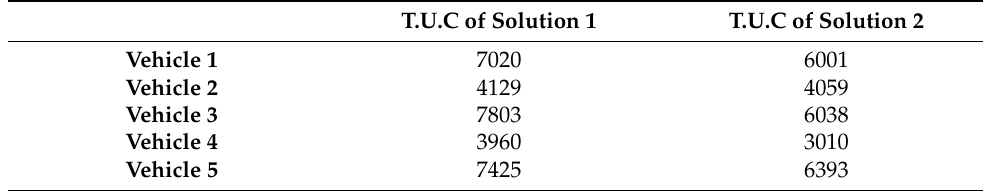
Table 8. T.U.C of each vehicle type.